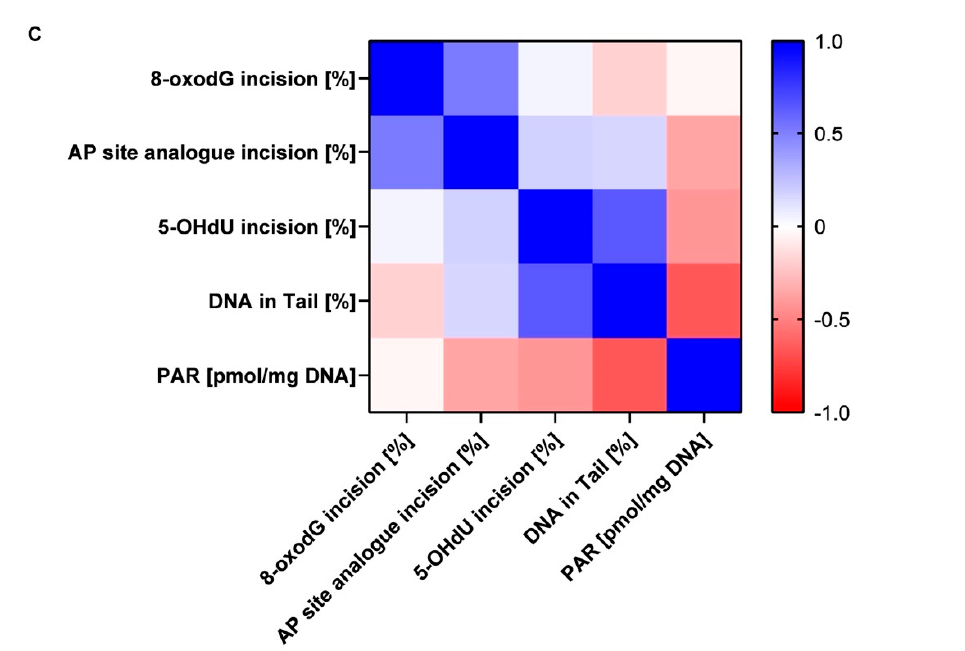
Figure 6. Relationships between genomic stability endpoints analysed by explorative correlation analysis. DNA damage and PARylation levels showed an inverse relationship ( A ) ( p = 0.002, Spearman’s R = -0.658), while DNA damage levels and incision activity towards the 5-OHdU containing oligonucleotide were positively related ( B ) ( p = 0.003, Spearman’s R = 0.651). The black line represents the linear regression. The correlation matrix-based heat map indicates Spearman’s correlation coefficient R between the analysed genomic stability endpoints ( C ).